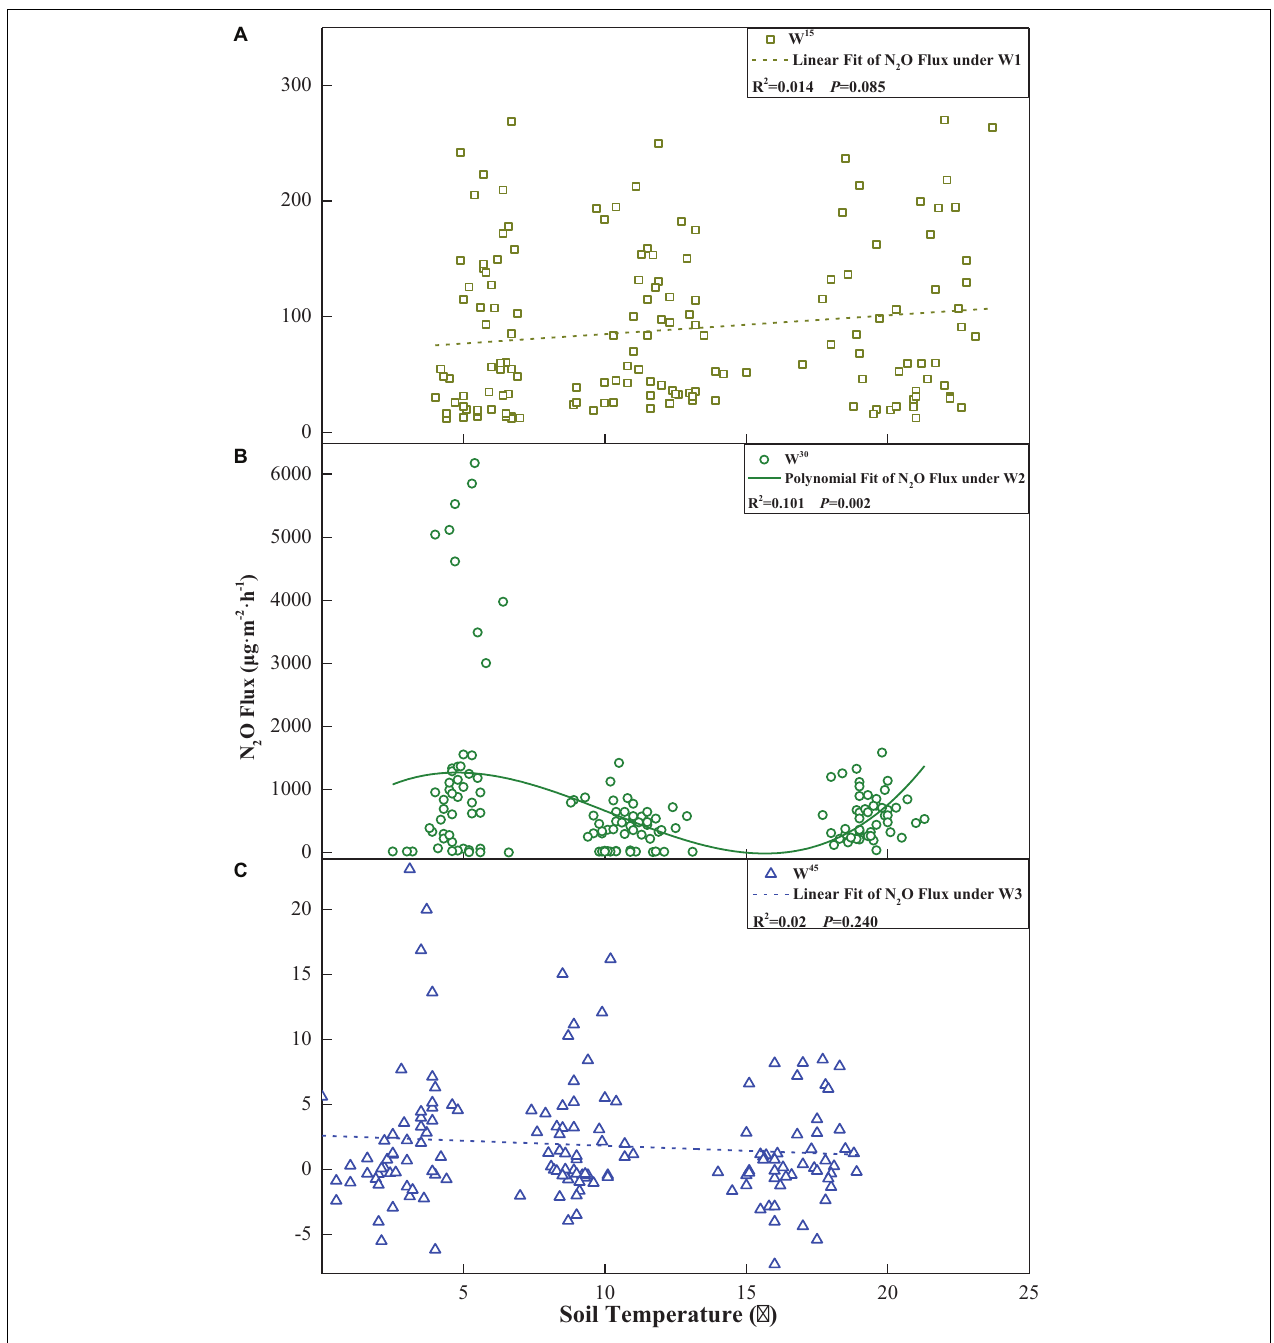
FIGURE 5 | The fitting results between N 2 O flux and thawing temperature under soil volumetric water content of (A) 15%, (B) 30%, and (C) 45%. Solid lines represent significant ( P < 0.05) fitted curves, while the dotted line are not significant ( P >